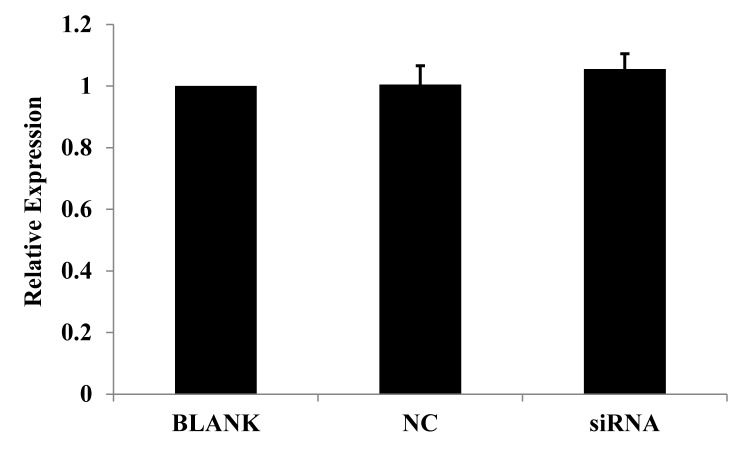
Effects of JWA siRNA on PANC-1 cell proliferation. PANC-1 cells were transfected with JWA siRNA and then seeded in 96-well plates and incubated with MTT following 24 h of transfection. The absorbance of each well was then measured. The proliferation of PANC-1 cells transfected by JWA siRNA was slightly higher than the other two groups, although the difference was not statistically significant (P>0.05). Data were normalized against the blank control set at 1. Error bars are the standard deviation. siRNA, small interfering RNA; NC, negative control; PANC-1, human pancreatic cancer cells.